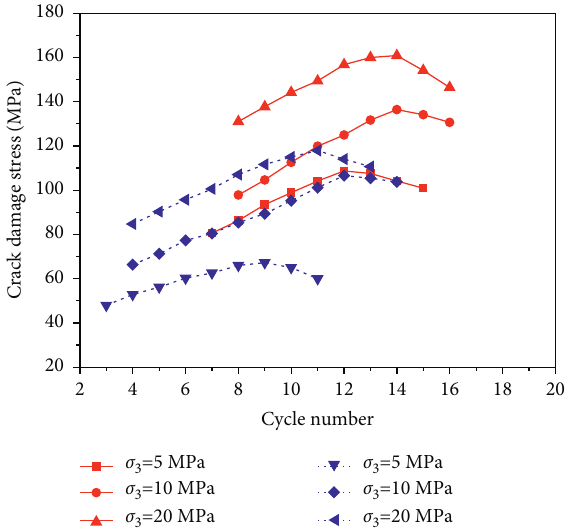
Figure 8: Relationship between crack damage stress and cycle number (blue denotes saturated phyllite and red denotes dry phyllite; σ 3 is the confining pressure).